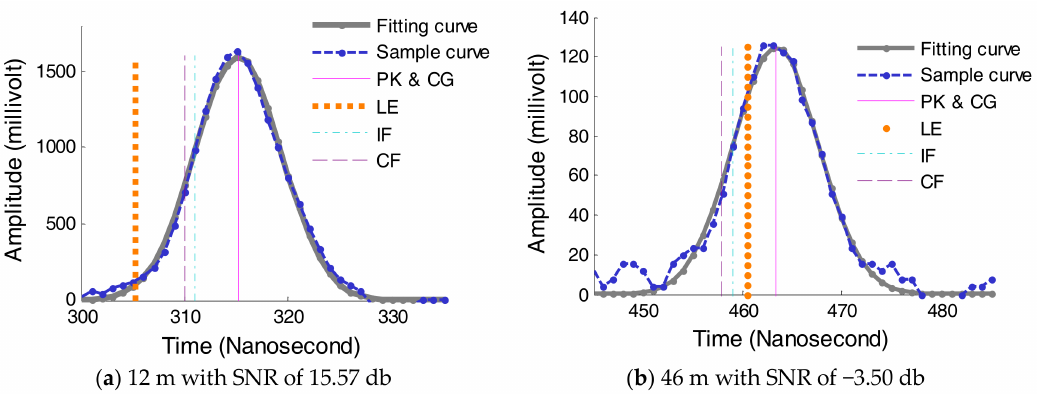
Figure 8. Five time discrimination on received waveform.